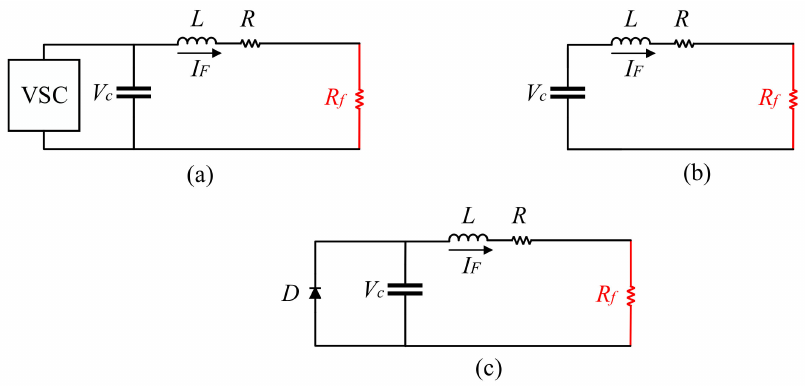
Figure 4. ( a ) Faulted network. ( b ) Stage 1 and ( c ) Stage 2